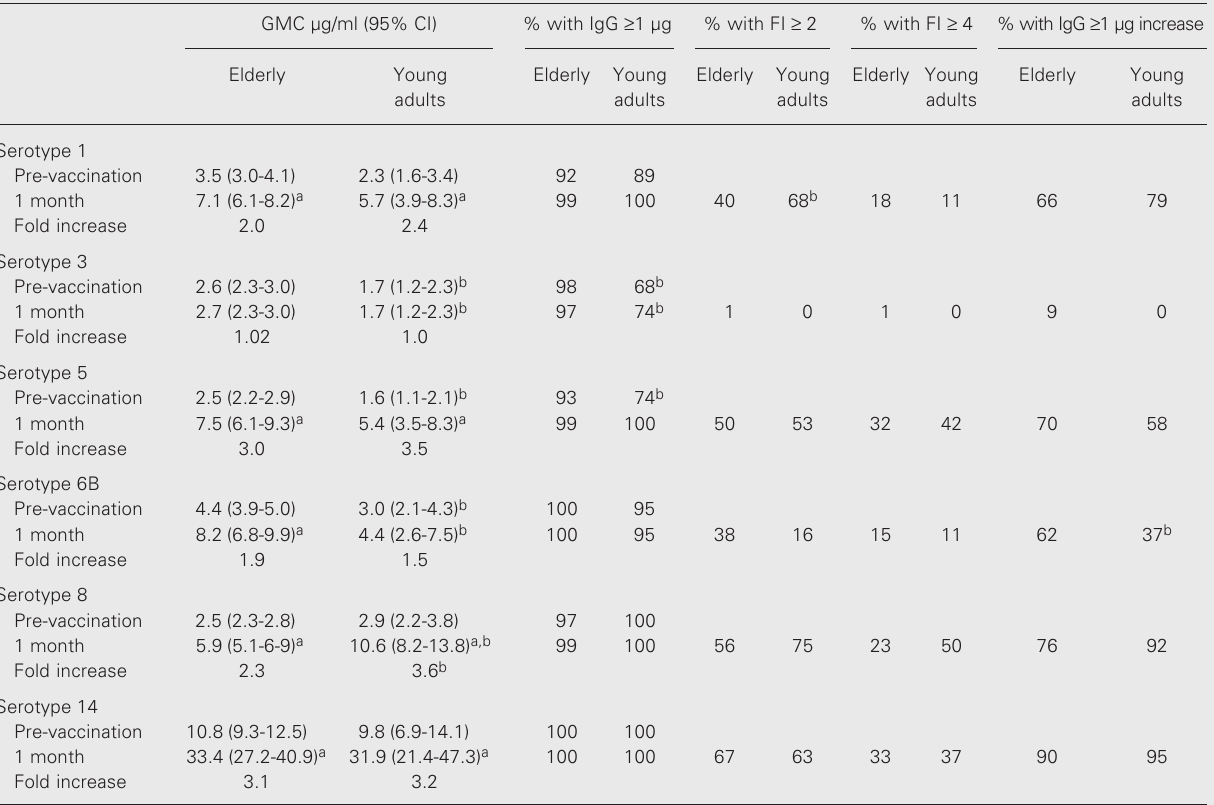
Table 1. Geometric mean concentration (GMC) and increases of IgG antibodies to 6 polysaccharides of Streptococcus pneumoniae in elderly (N = 102) and young adults (N =